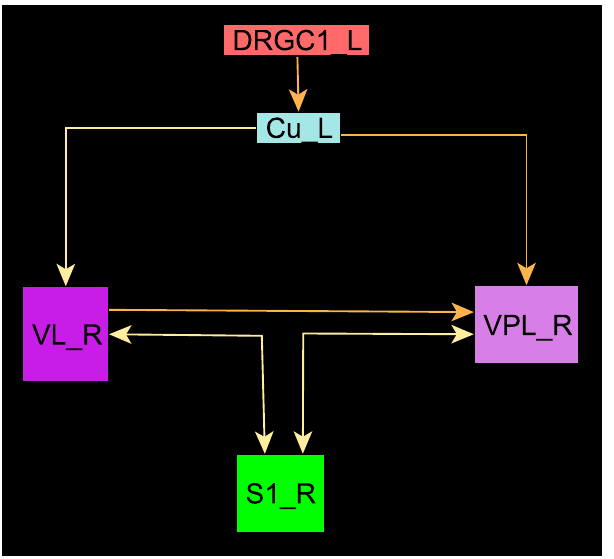
Fig 23. Network representation of the adjacency matrix. The network of the adjacency matrix of Fig 22 is visualized.